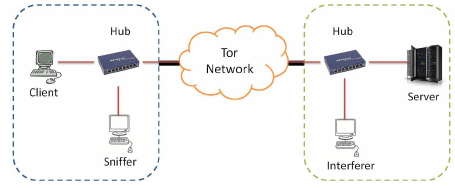
Figure 19: Experiment